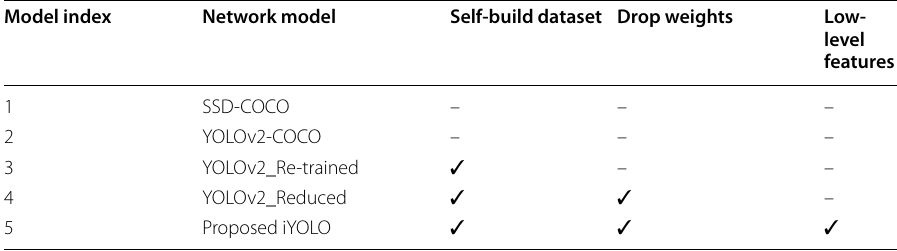
Table 1 Details of comparing detection network